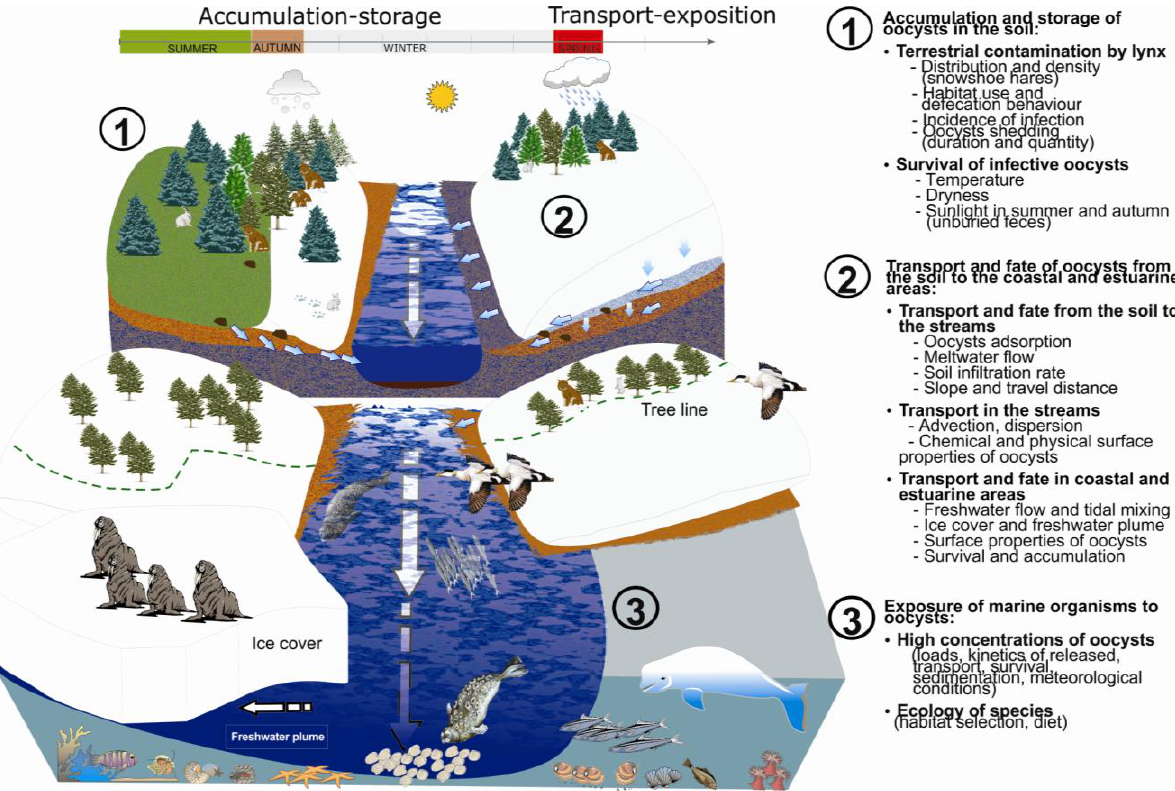
Figure 1. Watershed cross-section diagram showing the fate and transport of Toxoplasma gondii oocysts by the snowmelt runoff from the headwater to the estuary within the Canadian Arctic